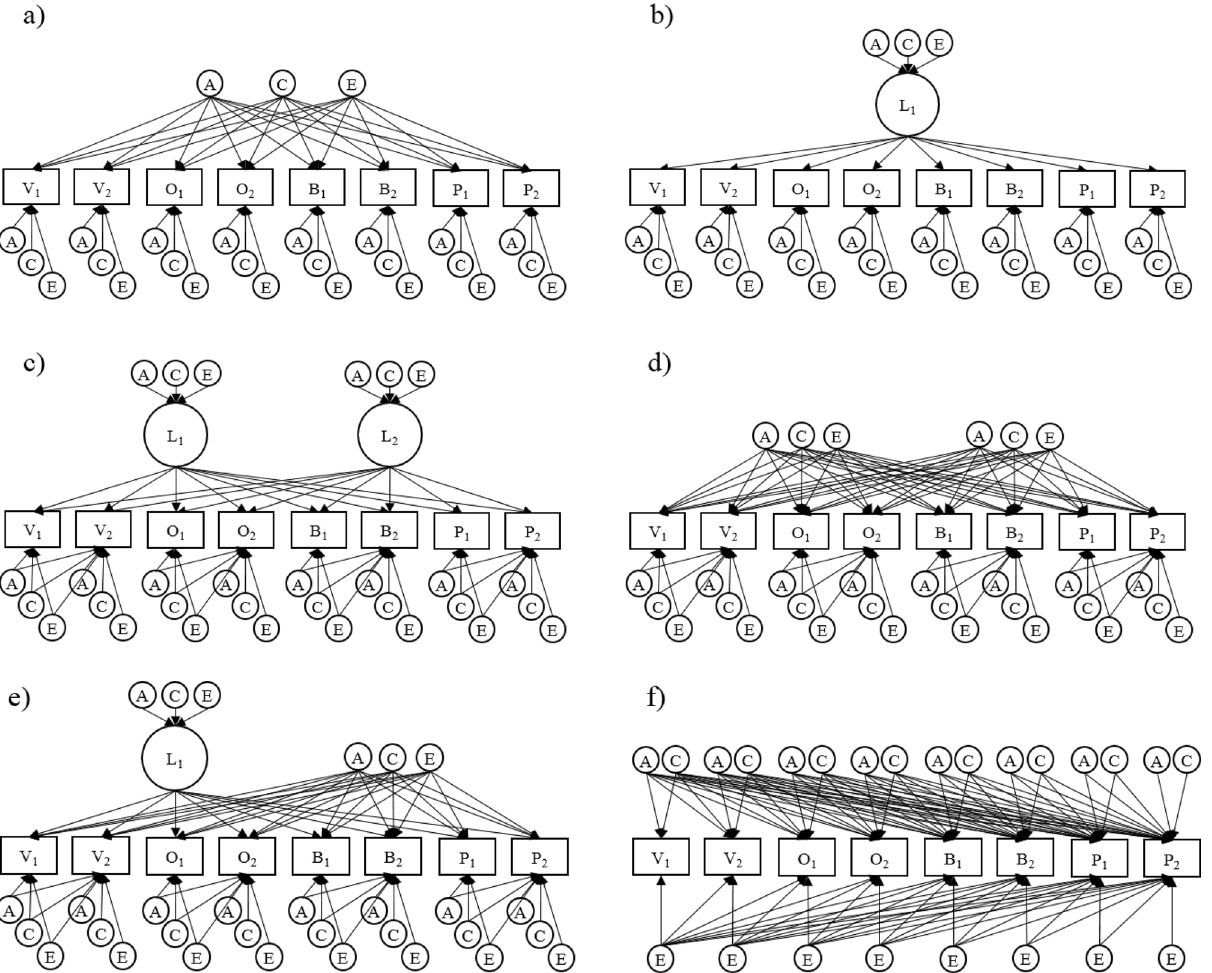
Figure 2. Illustrations of multivariate twin models. ( a ) 1-factor IP model; ( b ) 1-factor CP model; ( c ) 2-factor CP model allowing items from the same JS facet to share residual variance (the models in d and e also allow for this); ( d ) 2-factor IP model ( e ) hybrid model with one CP factor and one IP factor; ( f ) Cholesky model, working as our baseline for